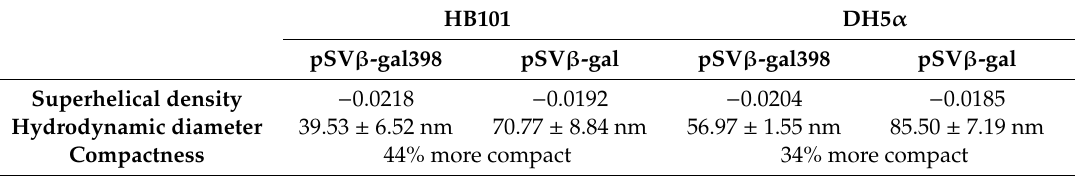
Figure 5. Particle size determination using the nanoparticle tracking analysis which tracks particle based on Brownian motion. Charts showing ( A ) the hydrodynamic diameter ( D h ) of linearized and nicked pSV β -gal398 plasmid and ( B ) the hydrodynamic diameter of supercoiled plasmid pSV β -gal398 and pSV β -gal in the two strains. The sizes are compared to the nicked and linearized plasmid which are larger than the supercoiled form of the plasmid. ( C ) and ( D ) show the particle size distribution of the plasmid pSV β -gal398 and pSV β -gal from the strain DH5 α . It shows the plot of diameter against concentration in particles / mL. The analyses were done in triplicate for all samples. Table 2. Superhelical density and hydrodynamic diameter of the plasmids amplified in di ff erent strains. The hydrodynamic diameter is expressed as mean + SEM and n =